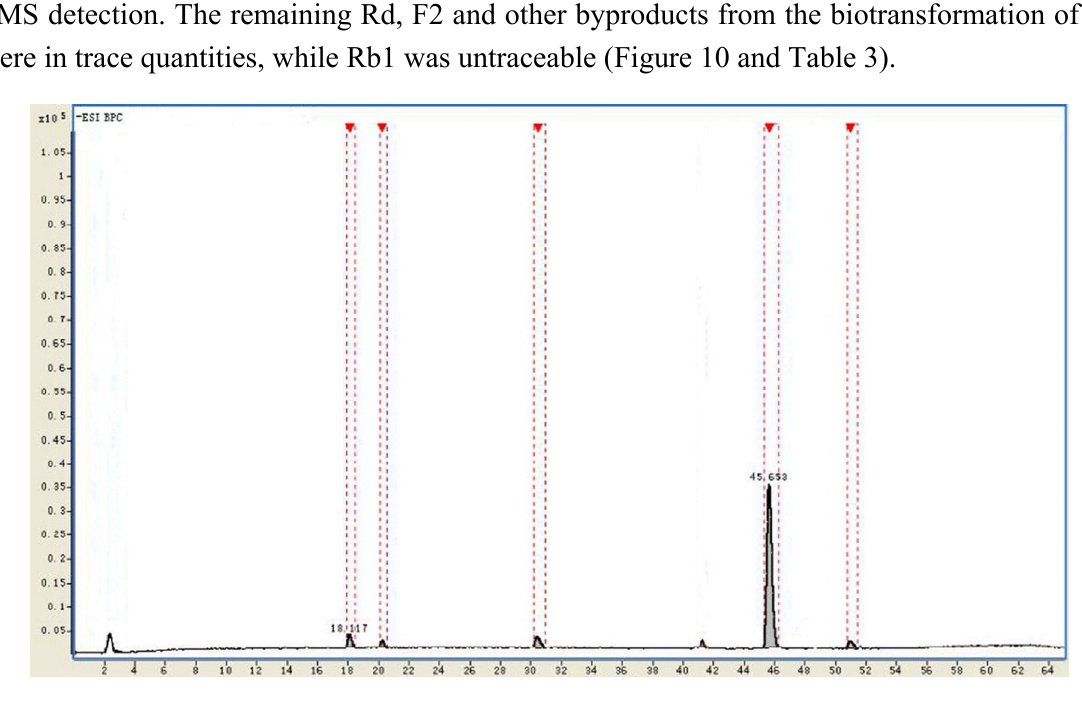
Figure 10. Normalization of BPC intensity by HPLC-Q-TOF-MS. Table 3. Relative concentration of ginsenoside Rd, F2 and CK after biotransformation.